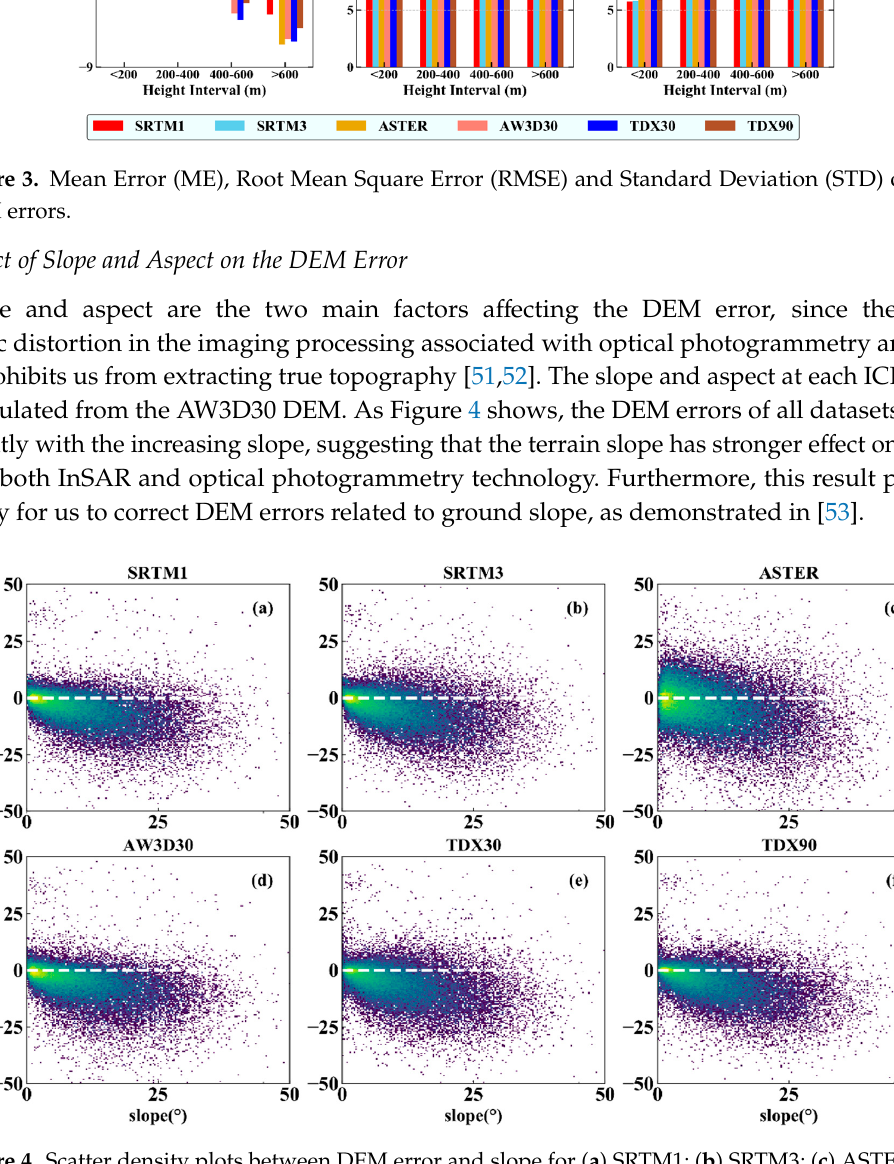
Figure 4. Scatter density plots between DEM error and slope for ( a ) SRTM1; ( b ) SRTM3; ( c ) ASTER; ( d ) AW3D30; ( e ) TDX30 and ( f ) TDX90. AW3D30; ( e ) TDX30 and ( f )